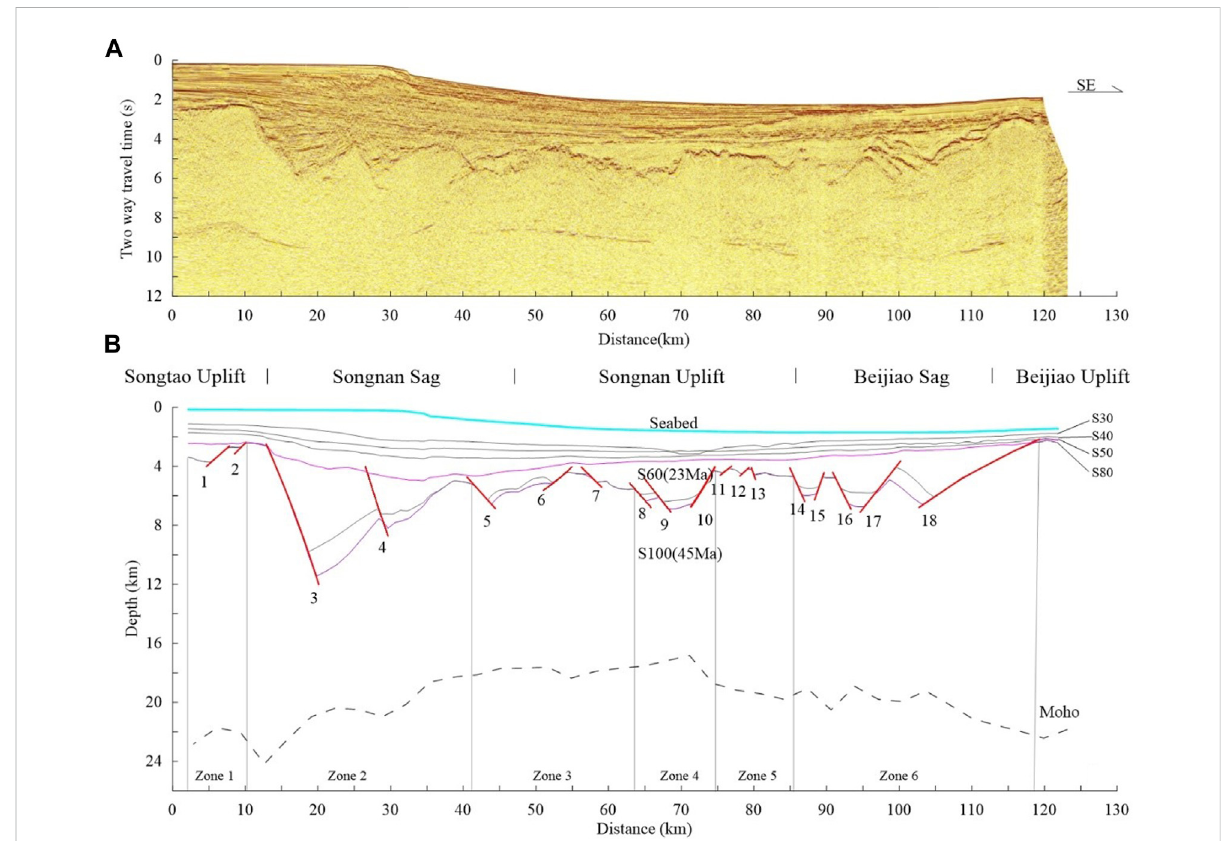
Figure 2) developed during the rifting were identi fi ed, which show variability in dips and sizes. F18 at the southeast end is the largest fault with greatest offset and low-angle dip. F3, F13, and F15 have steeper dip angles with θ > 50 ° . These faults, tilting SE and NW, compose a graben and half-grabens which exhibit features of both symmetric and asymmetric geometry. The pro fi le recorded re fl ectors of the stratigraphic unconformities and Moho depth with discontinuity. The unconformities at S100 (~45 Ma) and S60 (~23 Ma) correspond to the start and end of the syn-rifting,